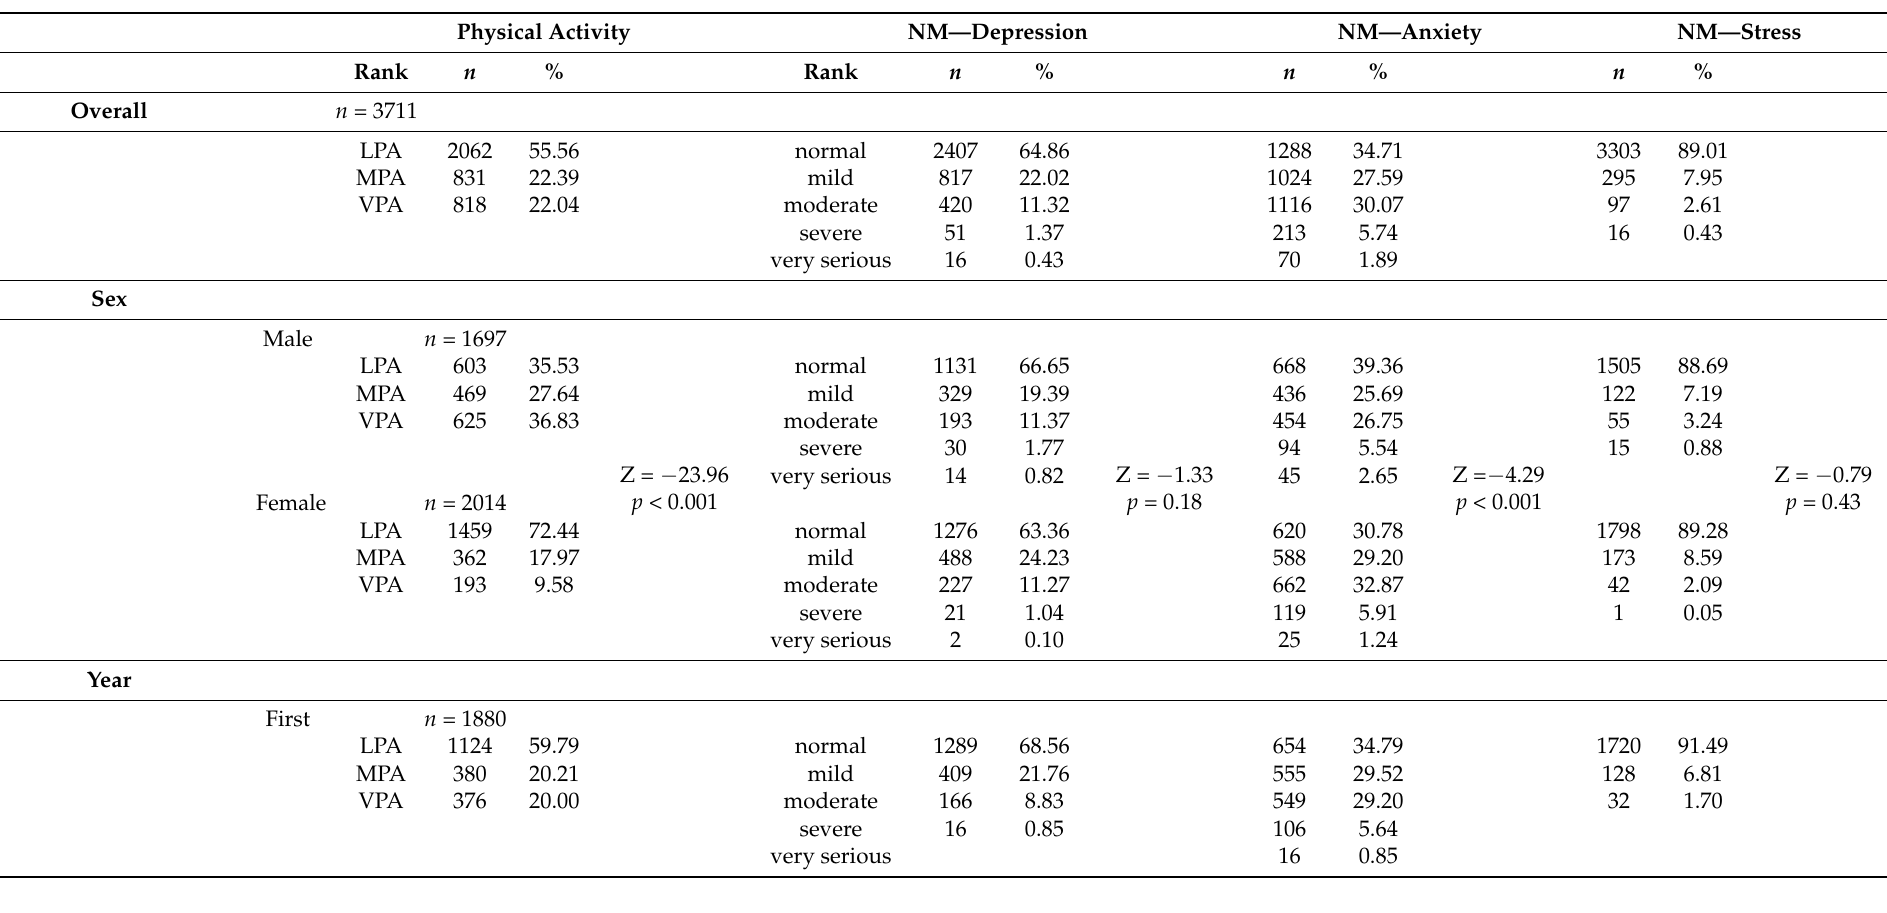
Table 2. The PA and NM characteristics of the college students ( n =